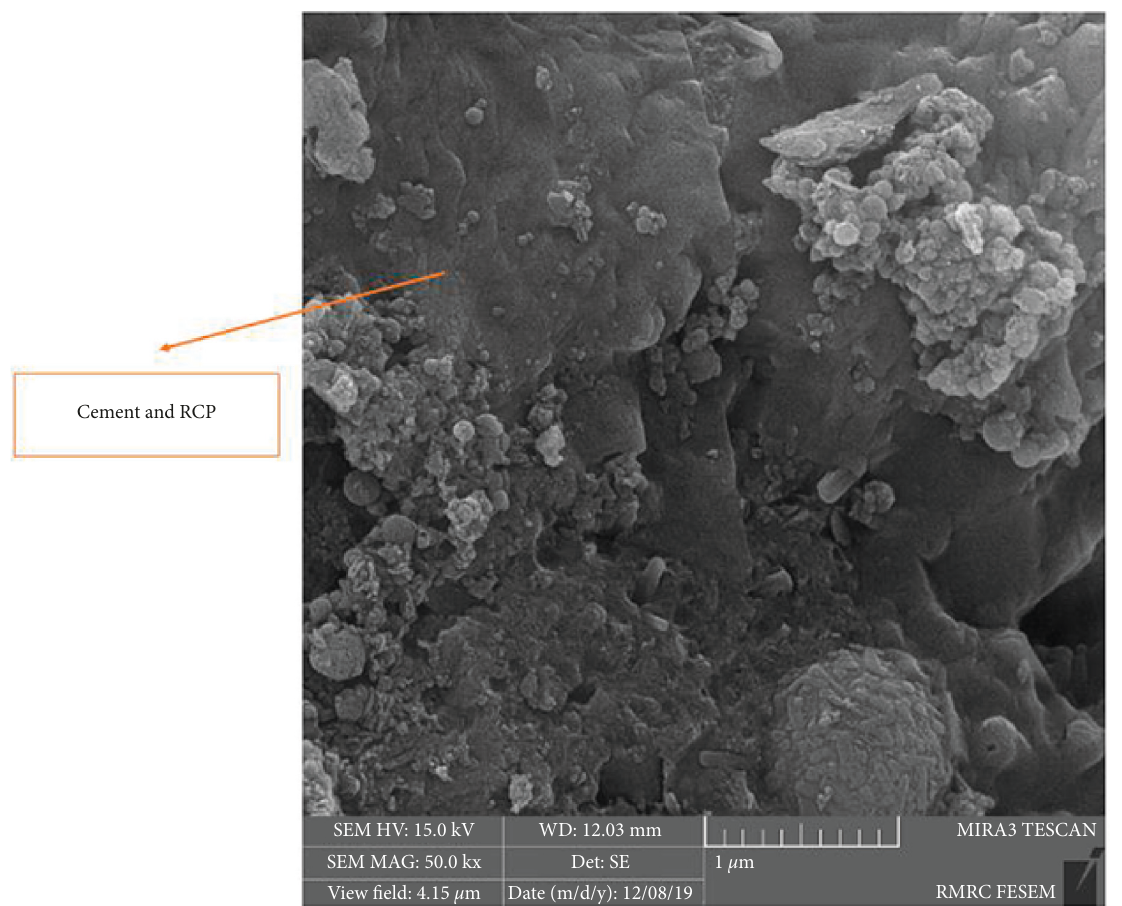
Figure 9: Cement hydration gel formation